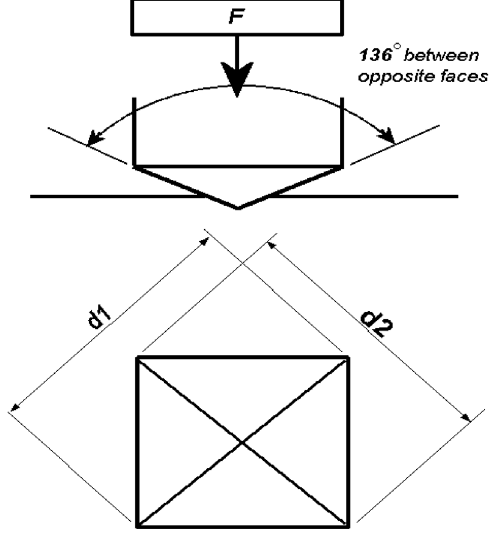
Fig. 1. Indentation geometry.